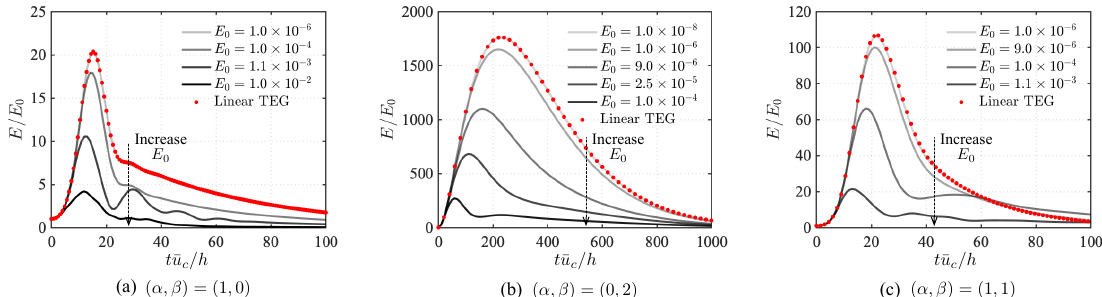
Figure 2. Transient energy growth (TEG) of optimal disturbance with a range of initial kinetic energy density E 0 from linear (red dots) and nonlinear (solid lines) simulations for uncontrolled